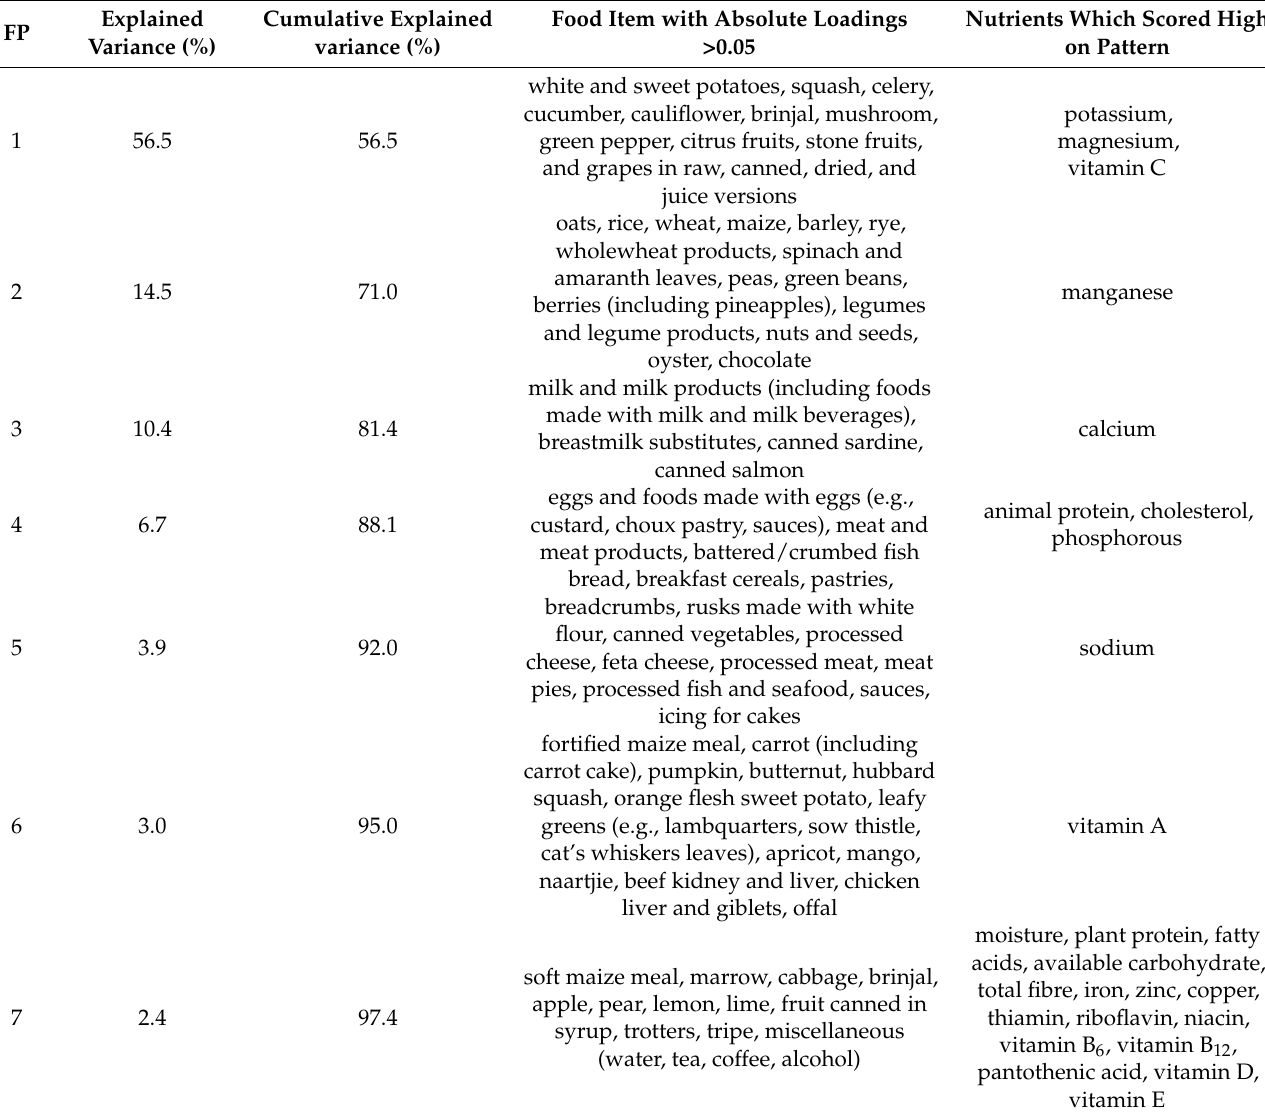
Table 5. Characterisation of food patterns